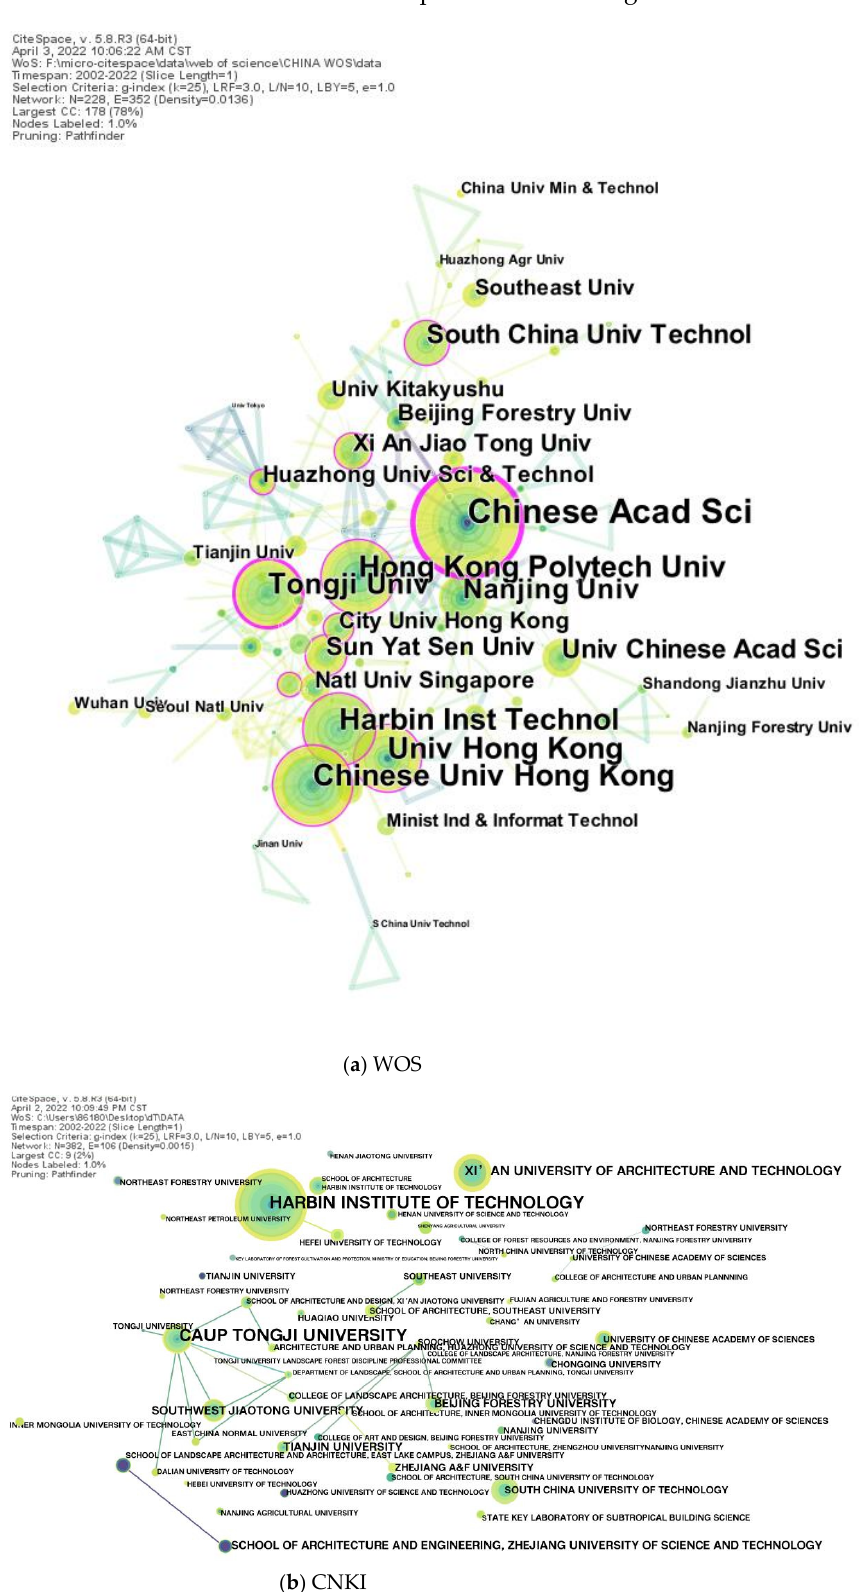
Figure 4. Institutional mapping of landscape microclimate in China. The mapping of foreign publishers had 512 nodes, 445 connections, and a network density of 0.0034(Figure 5). Arizona State University had the highest number of publica ‐ tions, with more than 30. From the perspective of geography, the countries affiliated with the publishing institutions were mainly located in the United States and Italy. The global distribution was uneven. Figure 5. Mapping of foreign publishing institutions in landscape microclimate.